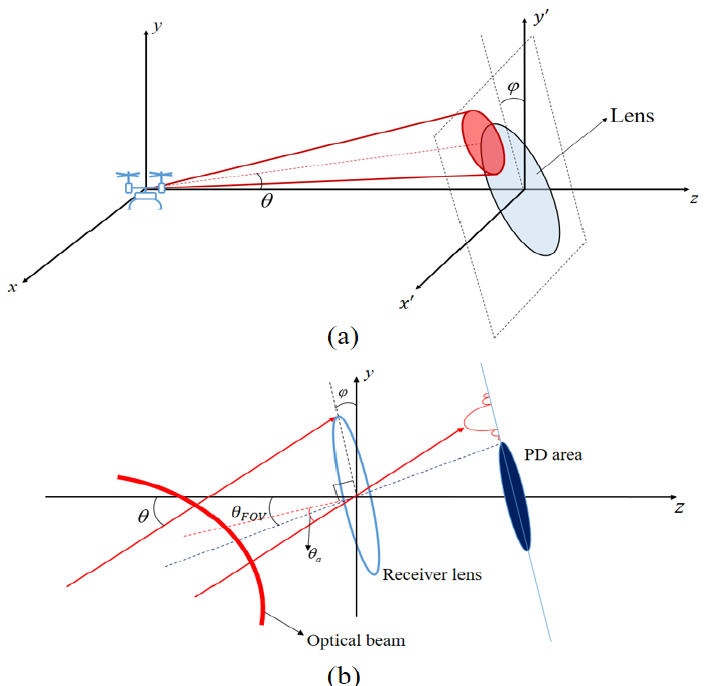
Figure 2. Schematic diagram of the receiving plane at the receiving end UAV. ( a ) 3D schematic diagram; ( b ) y-z plane diagram.